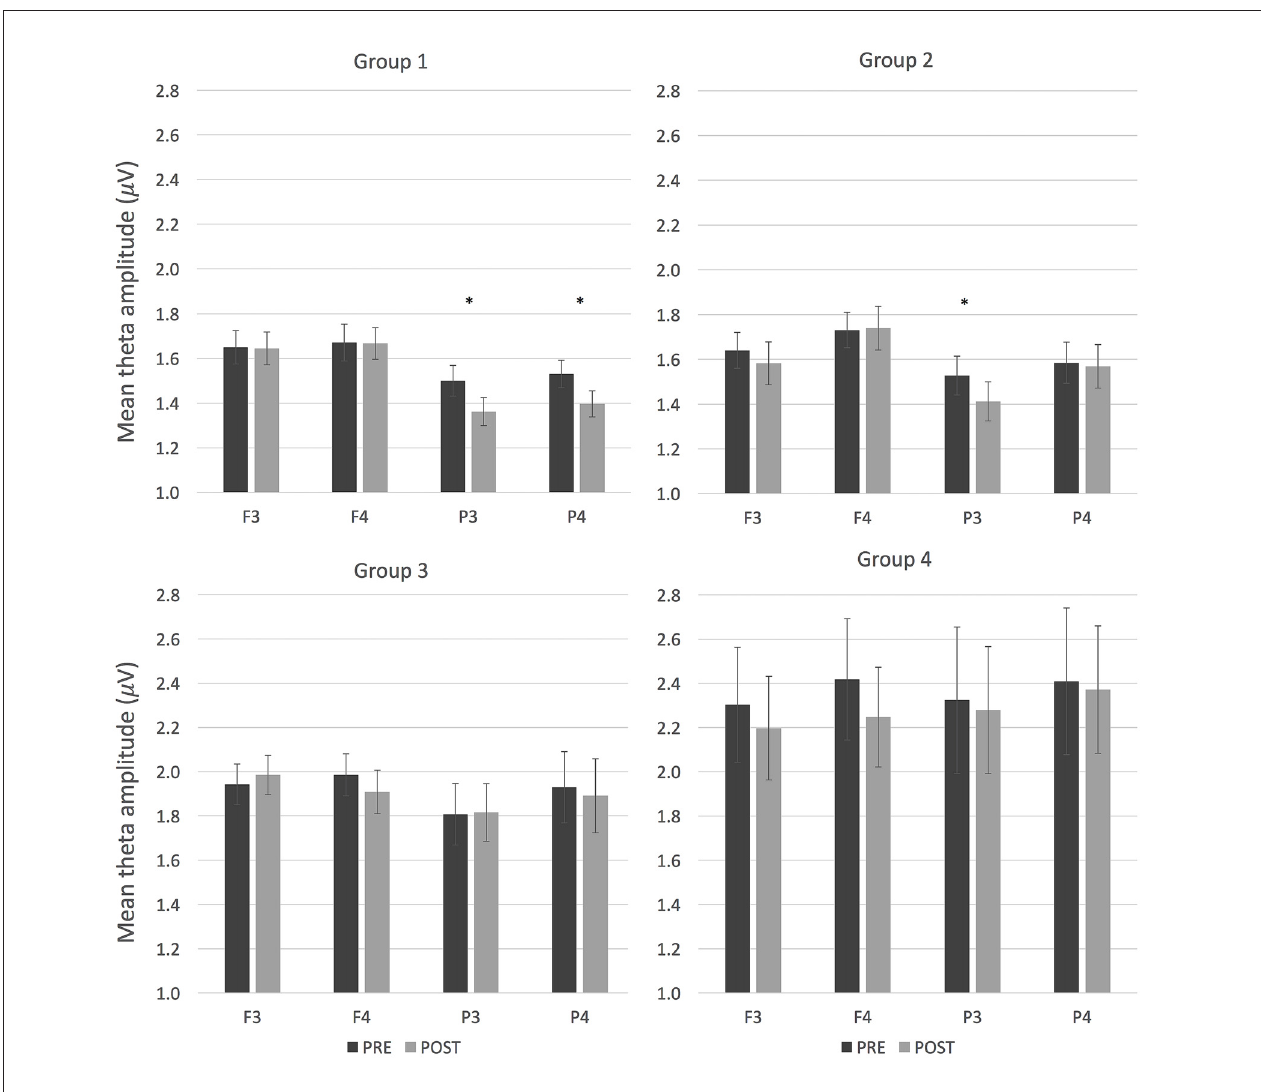
FIGURE 2 | Resting electroencephalogram (EEG) activity (mean theta amplitude) before and after theta tACS in the four groups. Error bars represent SEM. ∗ p <